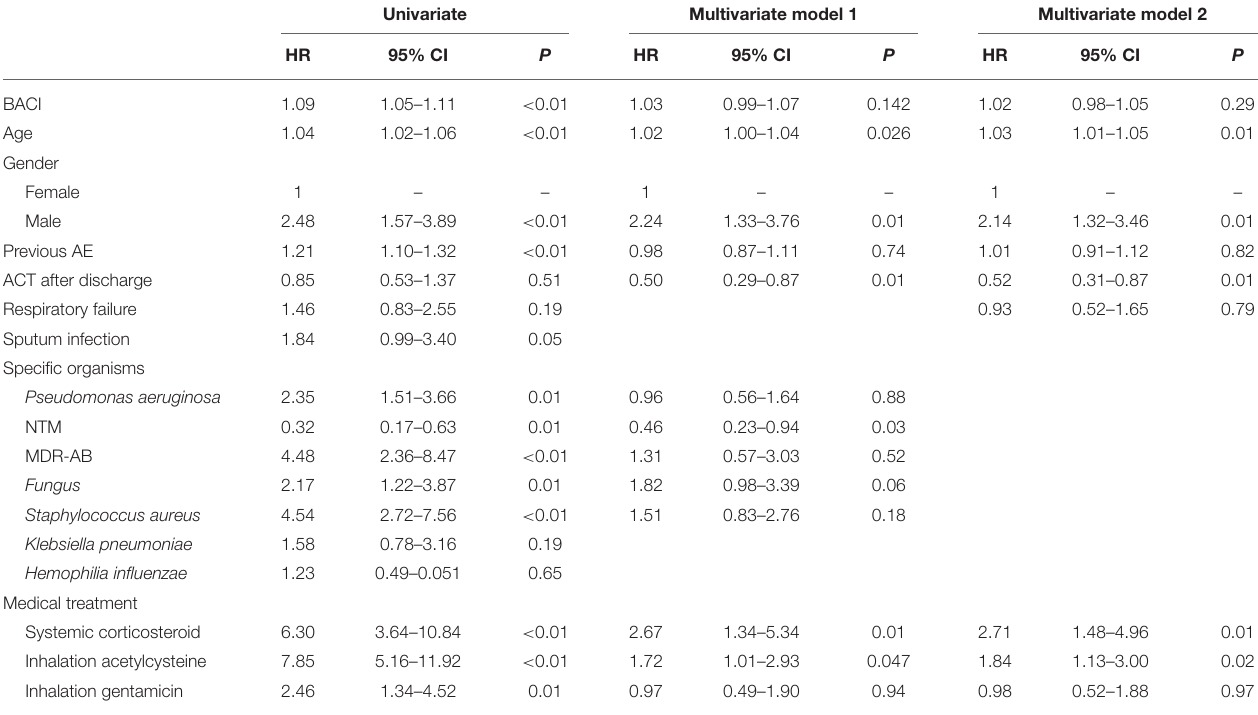
TABLE 4 | Univariate and multivariate analysis of 1-year mortality. Univariate Multivariate model 1 Multivariate model